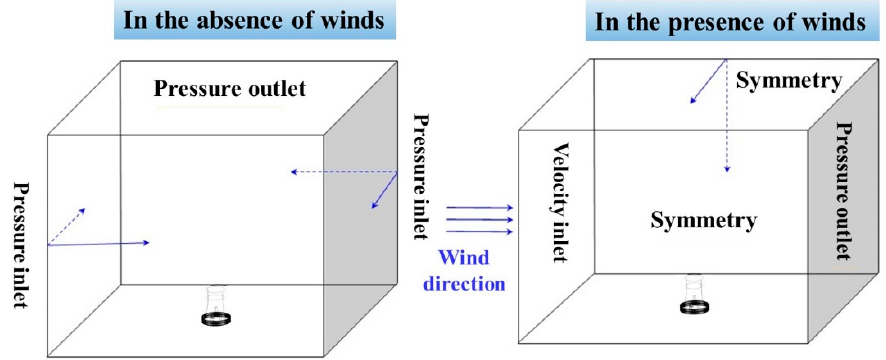
Figure 3. Computational domain and corresponding boundaries of NDDCS with one tower.